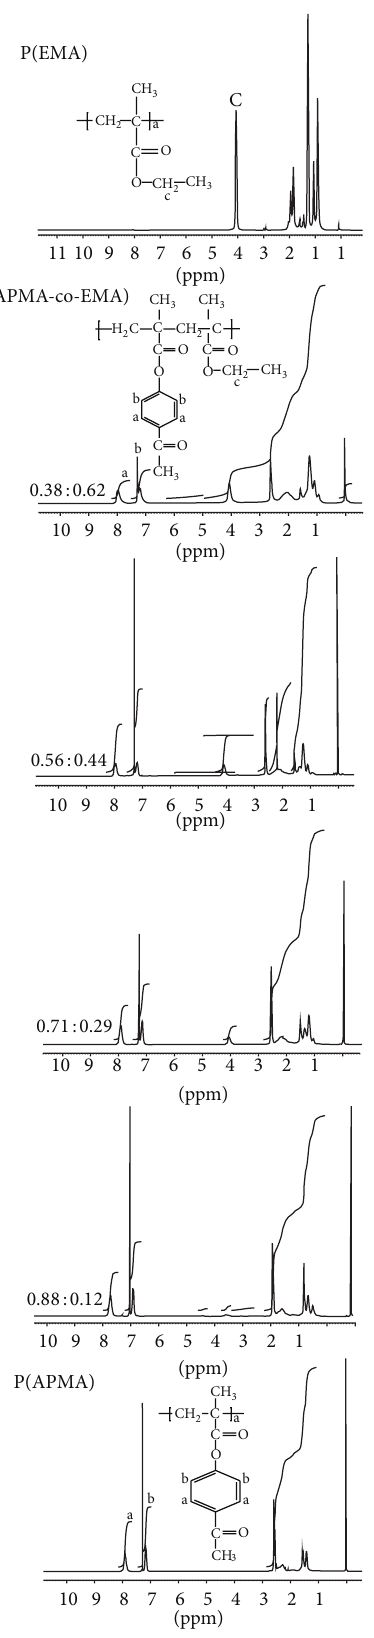
Figure 1: 1 H-NMR spectra of homopolymer and